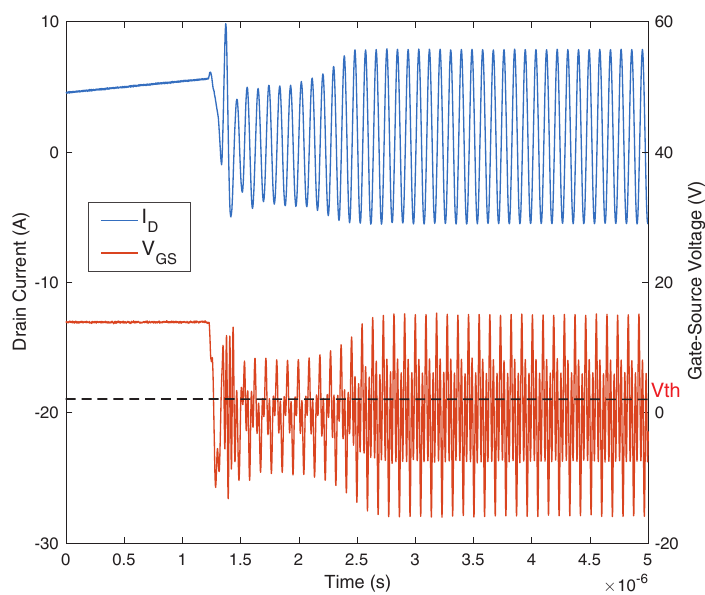
Figure 1. The self-sustained oscillation waveforms of gate voltage V GS and drain current I D